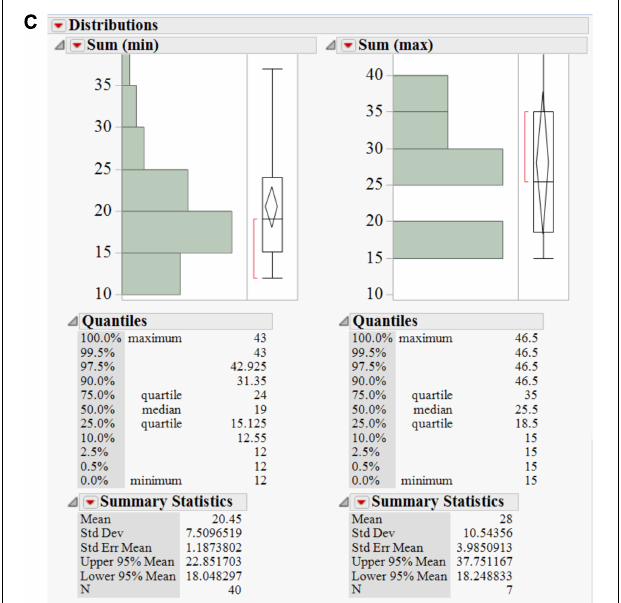
FIGURE 3 | Number of (A) nodes produced, (B) plastochrone interval, and (C) growth by centimeter in each (branch/axillary shoot) annually produced by Avicennia marina . Total number of branches measured n =